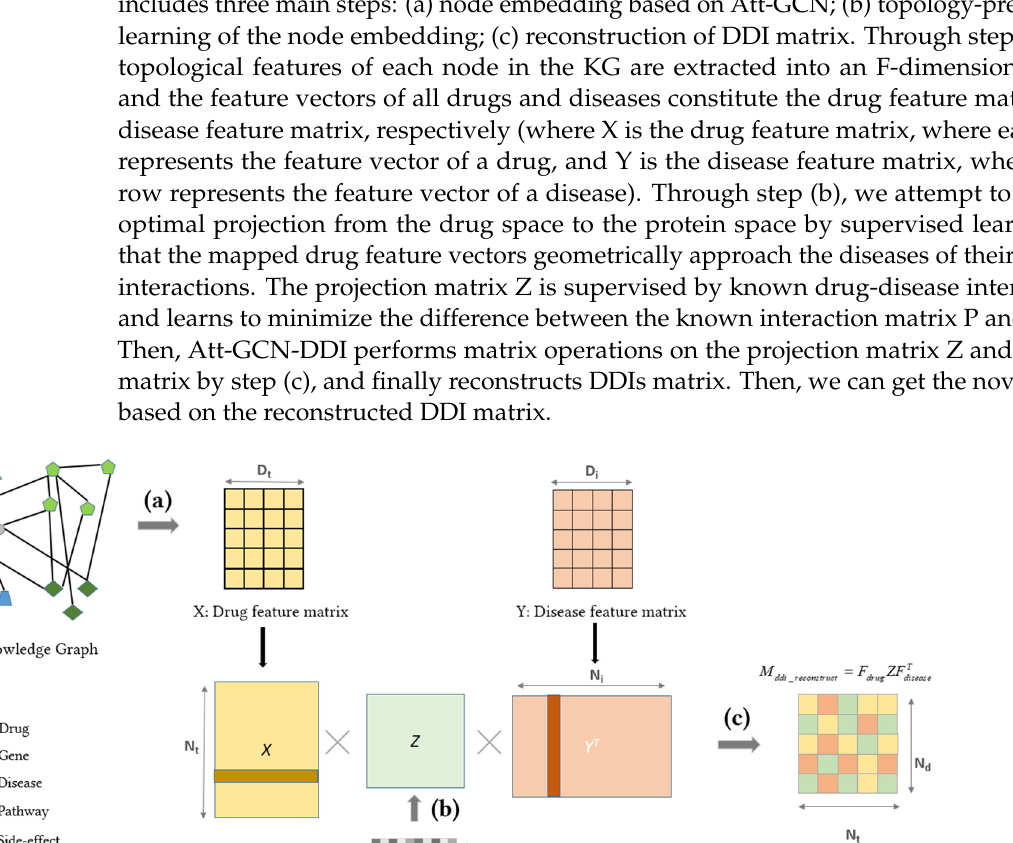
Table 2. The number of relations of each type in the KG for COVID-19.